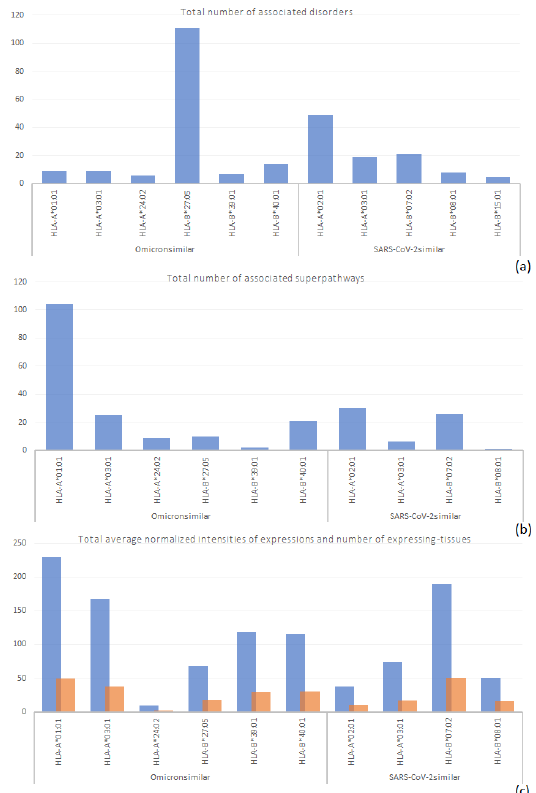
Figure 9. Total number of associated disorders, pathways, and expression levels (blue), along with the number of expressing tissues (orange), of the identified human proteins, with respect to the high affinity alleles of the viral peptide mimicking parts of those proteins. The total number of associated disorders reveals a possible risk in case of the HLA-B*27:05 serotypes ( a ). The total number of asso- ciated superpathways reveals a possible risk in case of the HLA-A*01:01 serotypes upon getting infected with the Omicron variant ( b ), which is supported by the total number of expression levels in ( c ). Collective data of approximately 7 – 8 identified proteins with the relevant information were used to plot the graphs.